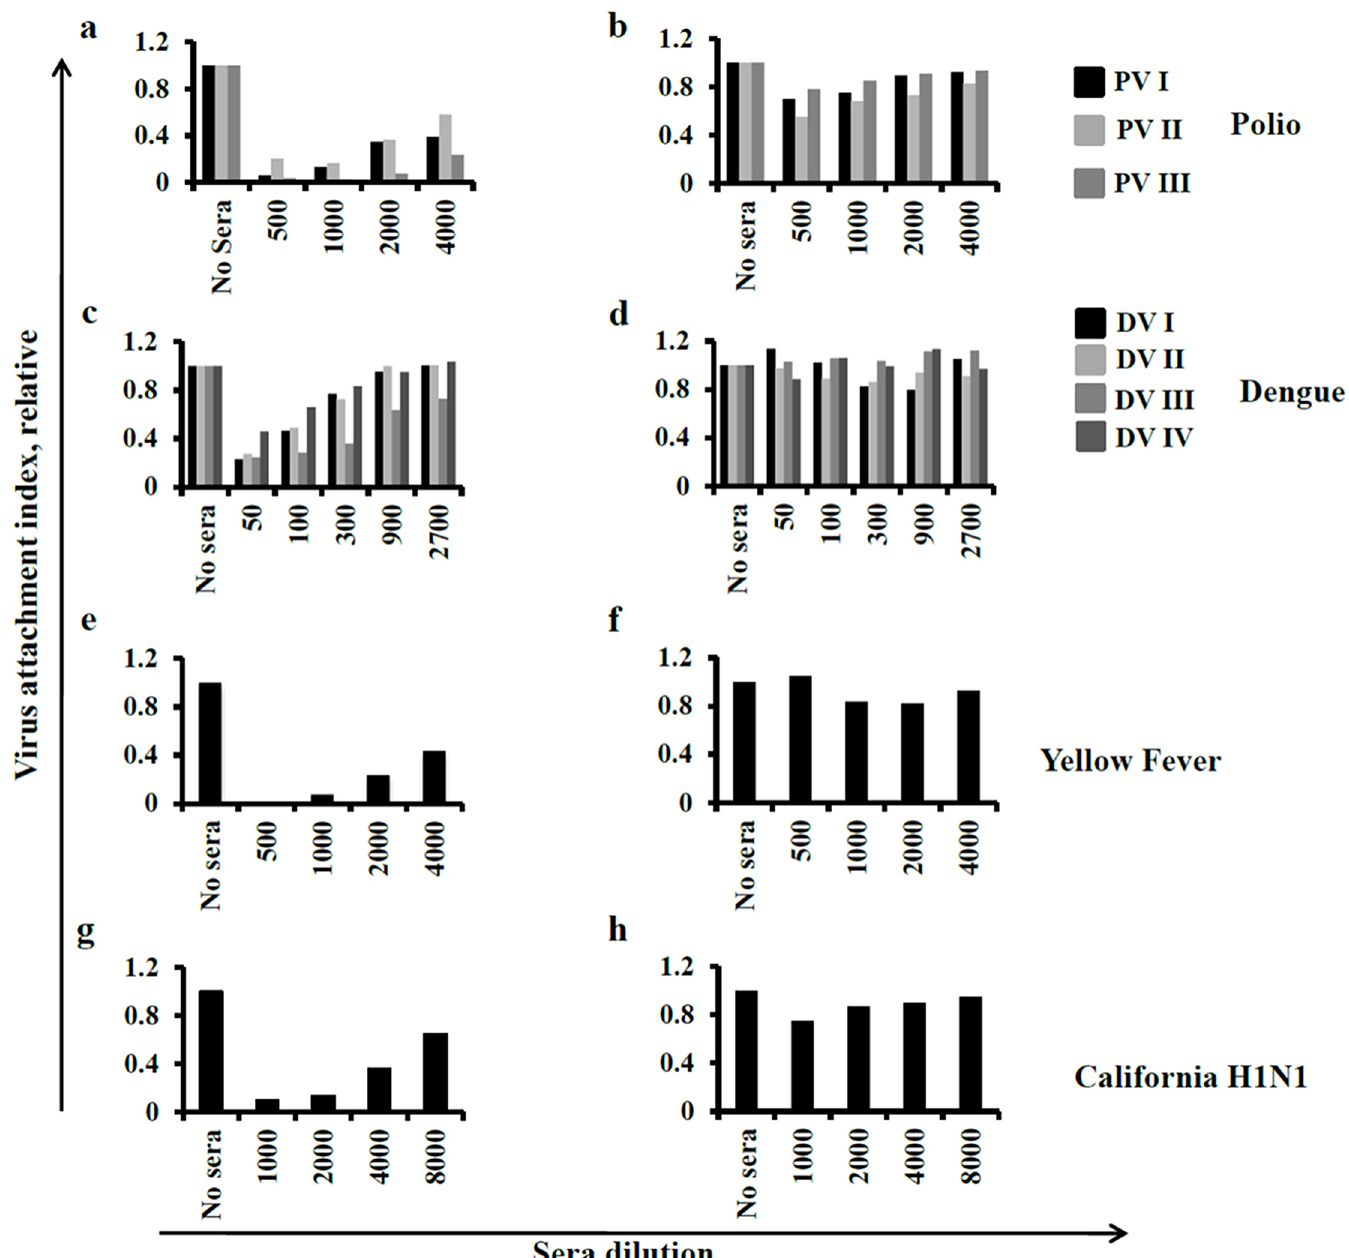
Fig 3. Proof of principle study for the fADI assay against different classes of viruses. fADI displayed a significant sera concentration dependent blocking of virus attachment for polioviruses of serotyopes I, II and III (A), Dengue I, II, III and IV (C), Yellow Fever (E) and influenza California H1N1viruses (G) to Vero cells. The sera used in the demo experiments were standard hyper-immune sera specific to the corresponding viruses. Control ELISA (B, D, F and H) tests with those standard sera did not display any significant reduction in fluorescent signal thus showing very low or no competition between the sera antibodies and virus specific labeling antibodies used in the